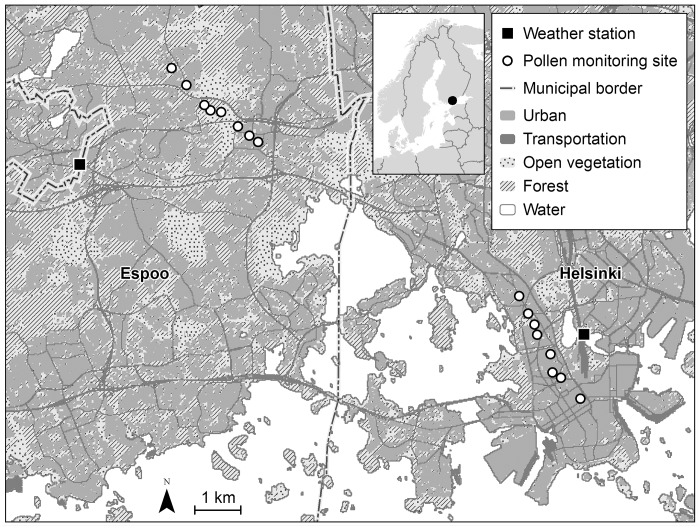
Map of the study area.Background map contains data from the General map 1:4 500 000 by the National Land Survey of Finland and the CLC2012 dataset by SYKE (partly Metla, Mavi, LIVI, VRK, MML Maastotietokanta 05/2012), licensed under a Creative Commons BY 4.0 International License (http://creativecommons.org/licenses/by/4.0/).